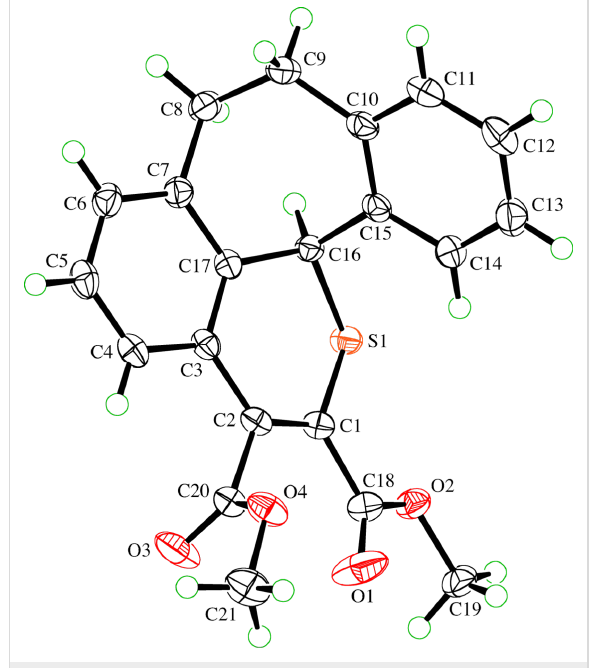
Figure 1: ORTEP Plot [19] of the molecular structure of 4b , drawn using 50% probability displacement ellipsoids.